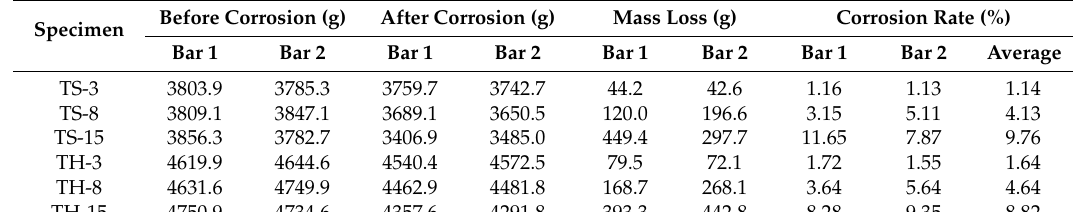
Table 2. Measured corrosion rates of test specimens.